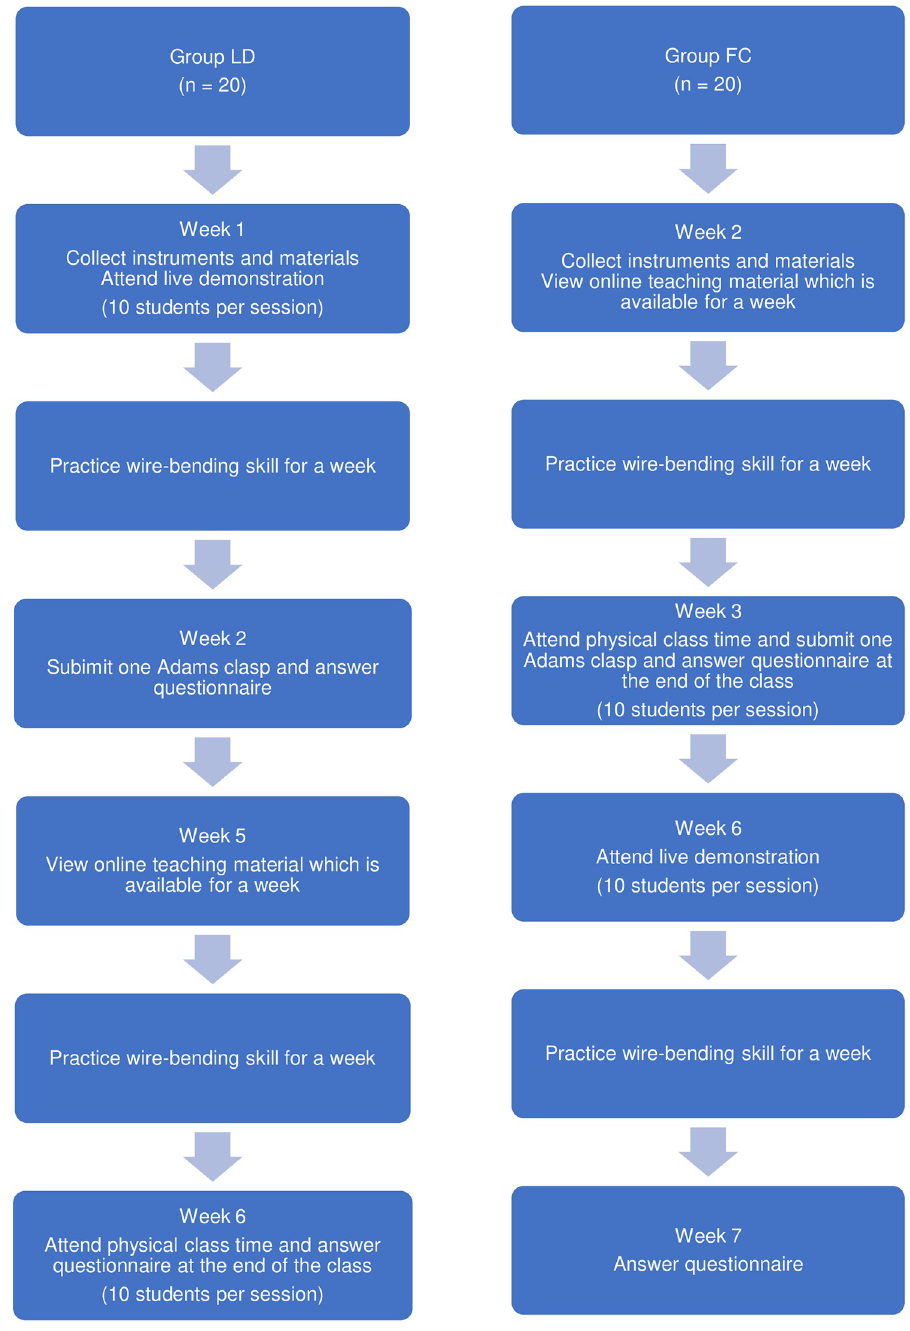
Fig 1. Flowchart of the research